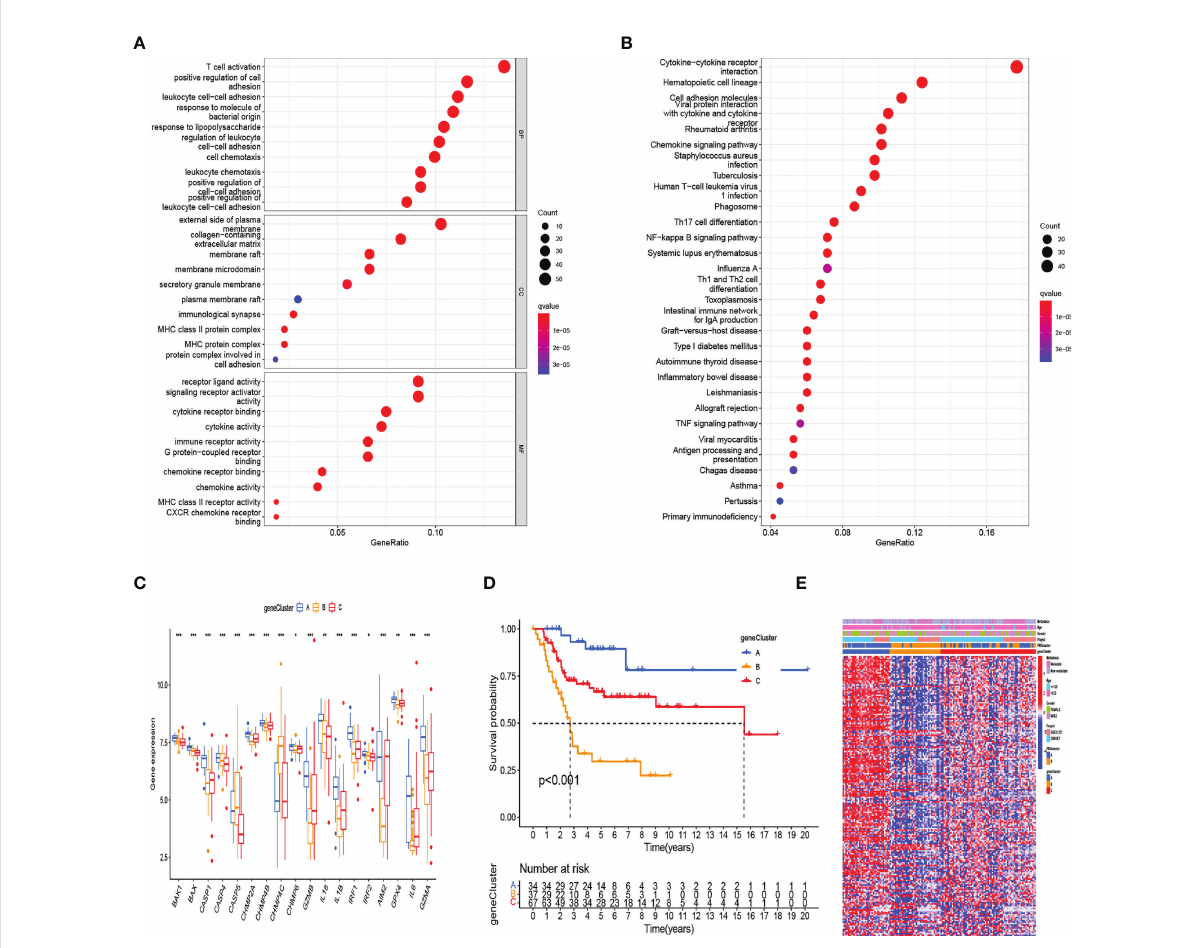
FIGURE 3 Identi fi cation of gene subtypes based on DEGs between two RRG clusters. (A, B) The functional enrichment analysis of DEGs among two PRGclusters. (C) The differential expressions of 18 PRGs among the three gene subtypes. (***:p value <0.001, **:p value <0.01, *:p value <0.05) (D) Kaplan – Meier analysis for overall survival of the three gene subtypes. (E) Relationships between clinicopathologic features and the two gene subtypes. DEGs, differentially expressed genes; PRGs, pyroptosis-related